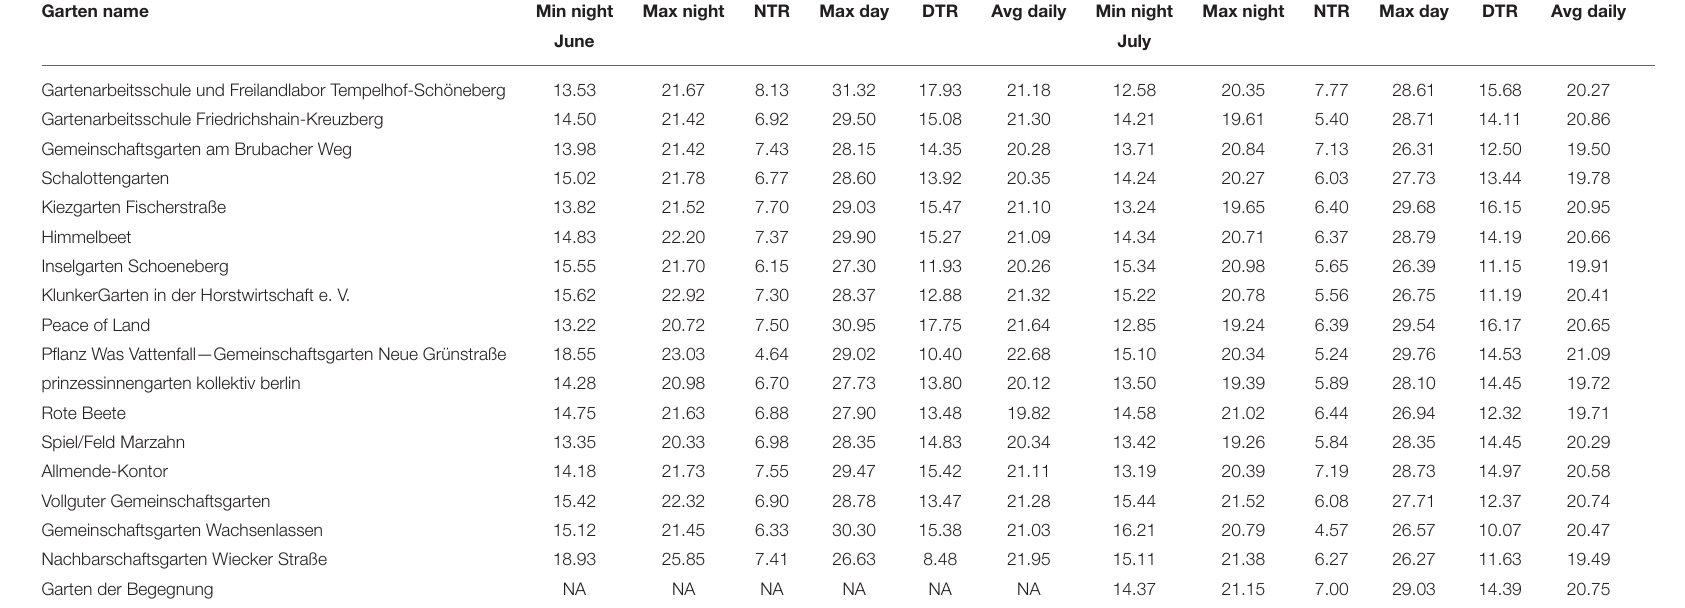
Values are the daily values averaged across the recording periods for each respective time period (June, July) (Min = minimum; Max = maximum; Avg = average; NTR = nocturnal temperature range; DTR = diurnal temperature